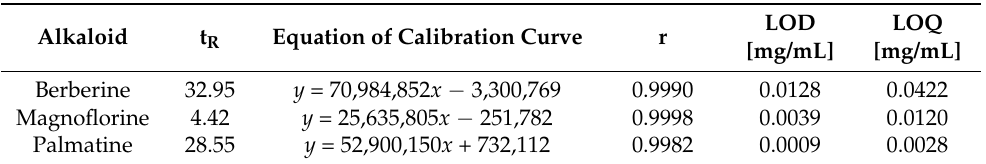
Figure 1. Chemical structures of investigated isoquinoline alkaloids. Table 1. Retention times and equation of calibration curve, correlation coefficients (r), limit of detection (LOD) and limit of quantification (LOQ) values for studied isoquinoline alkaloids.